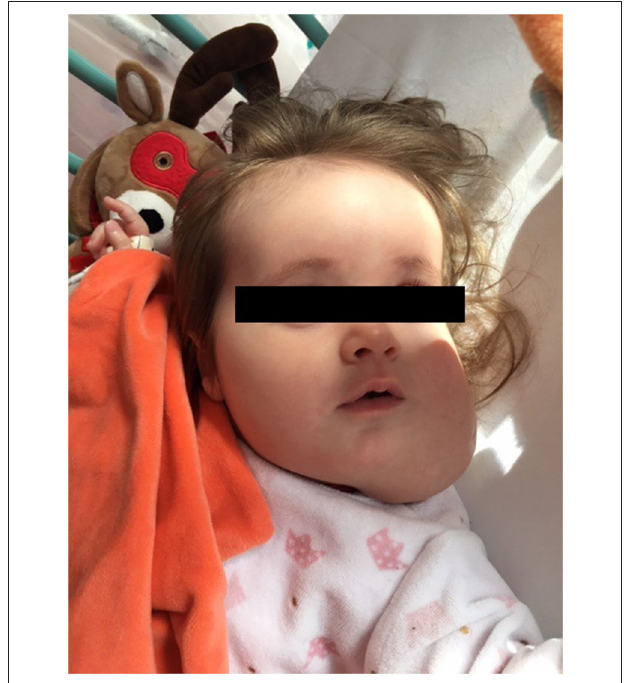
FIGURE 3 | Photograph illustrating the clinical aspect of the cervical mass at 12 months of life.